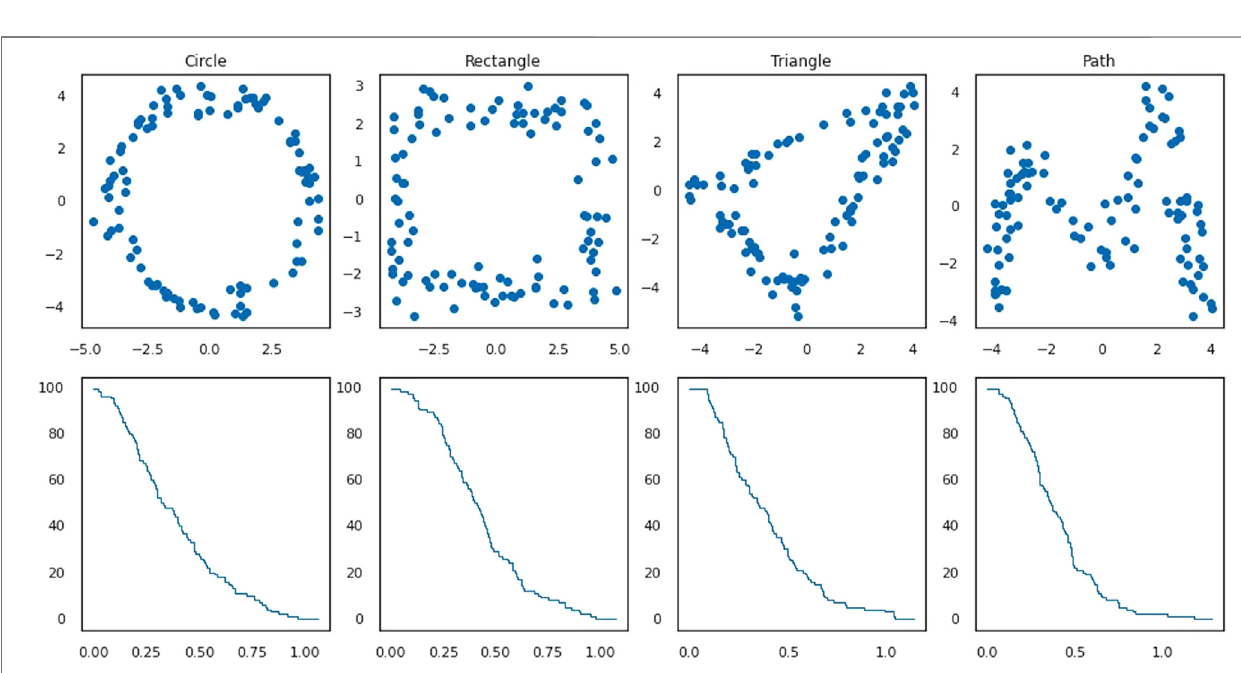
Frontiers in Applied Mathematics and Statistics |